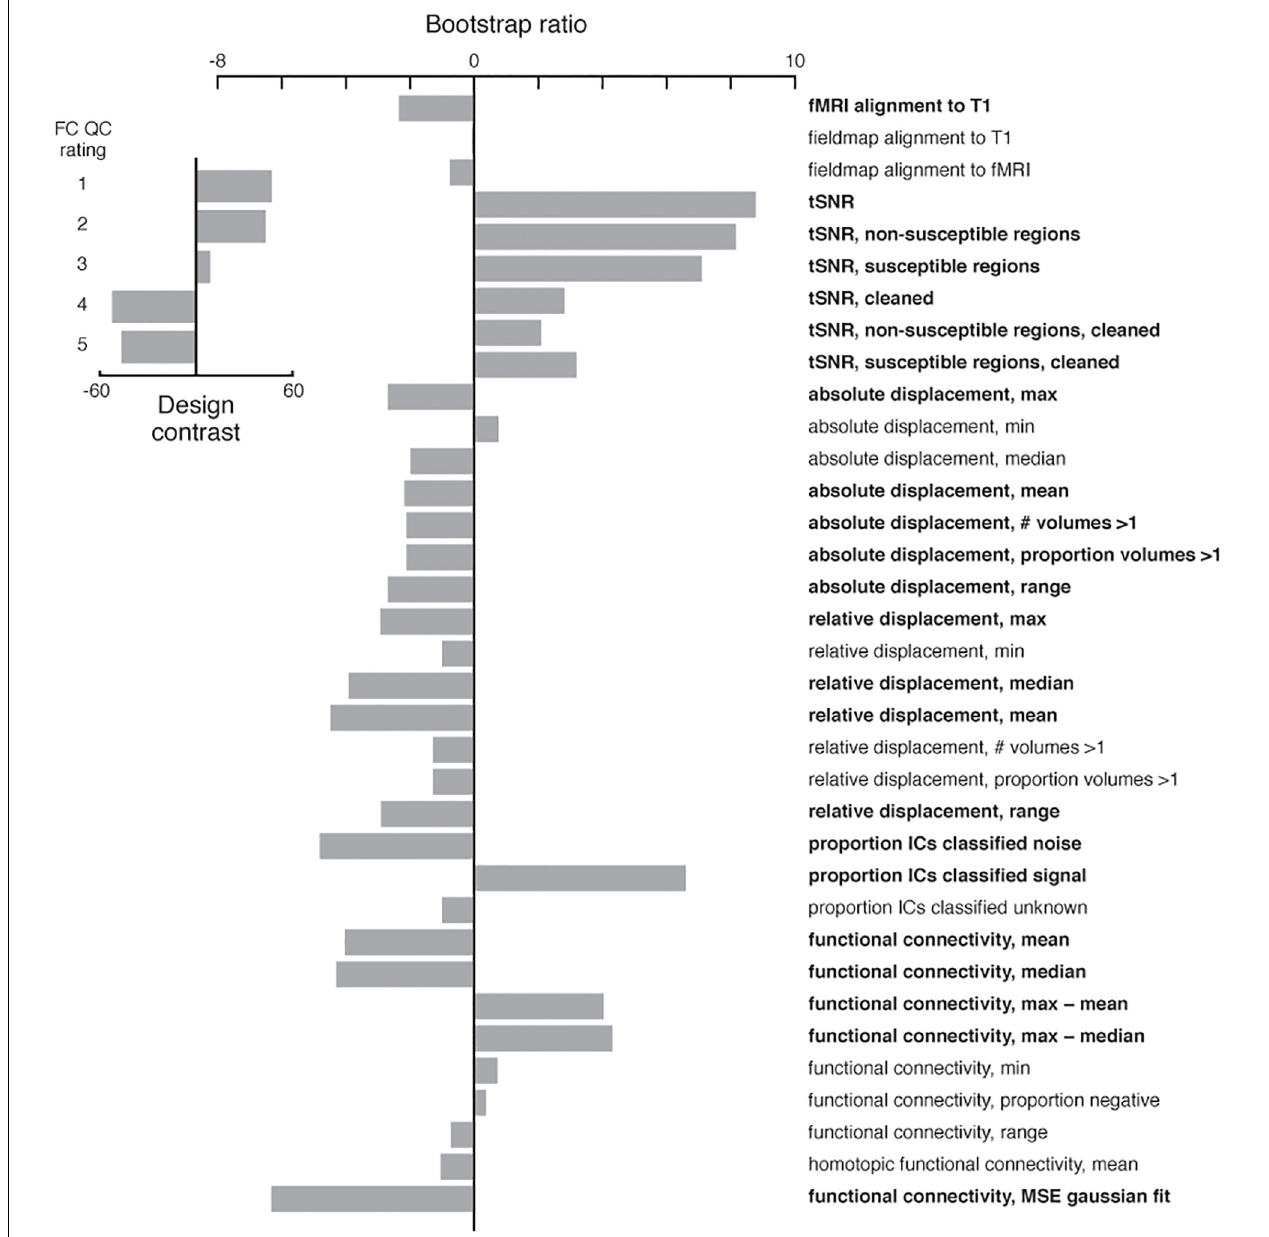
FIGURE 11 | Partial least squares analysis of functional sub-pipeline IDPs and summary statistics as a function of the functional connectivity QC rating. The analysis returned a contrast (inset) between good (1 and 2) and bad (4 and 5) scores. The most reliable indicators of a good QC rating included high temporal signal-to-noise ratios, low relative displacement, a higher proportion of ICA components classified as signal, and Gaussian-like functional connectivity distributions. IDPs and summary statistics with an absolute value bootstrap ratio > 2 were considered reliable (see Section “Method”), and are indicated in